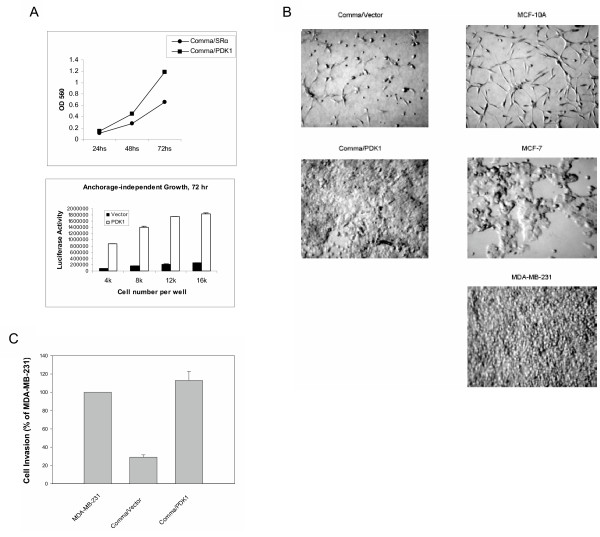
PDK1 increases anchorage-dependent and -independent cell growth and ECM invasion. A, Top panel, Cell growth on a plastic substrate was determined after 24–72 hr by SRB staining as described in Methods. Results are expressed as the OD560 at each time point. Lower panel, Anchorage-independent growth was determined by seeding cells in siliconized plates and determining growth after 72 hr by assay for ATP using luciferase as described in Methods. Results are expressed in units of luciferase activity. B, Cells were grown for 7 days on collagen-coated plates. Magnification 50×. C, Cells were grown on Matrigel in a Boyden chamber and cells invading through Matrigel were determined. Results are expressed as a percentage of MDA-MB-231 cells invading Matrigel run in parallel as a positive control, and represent the mean ± S.E. of three independent experiments.